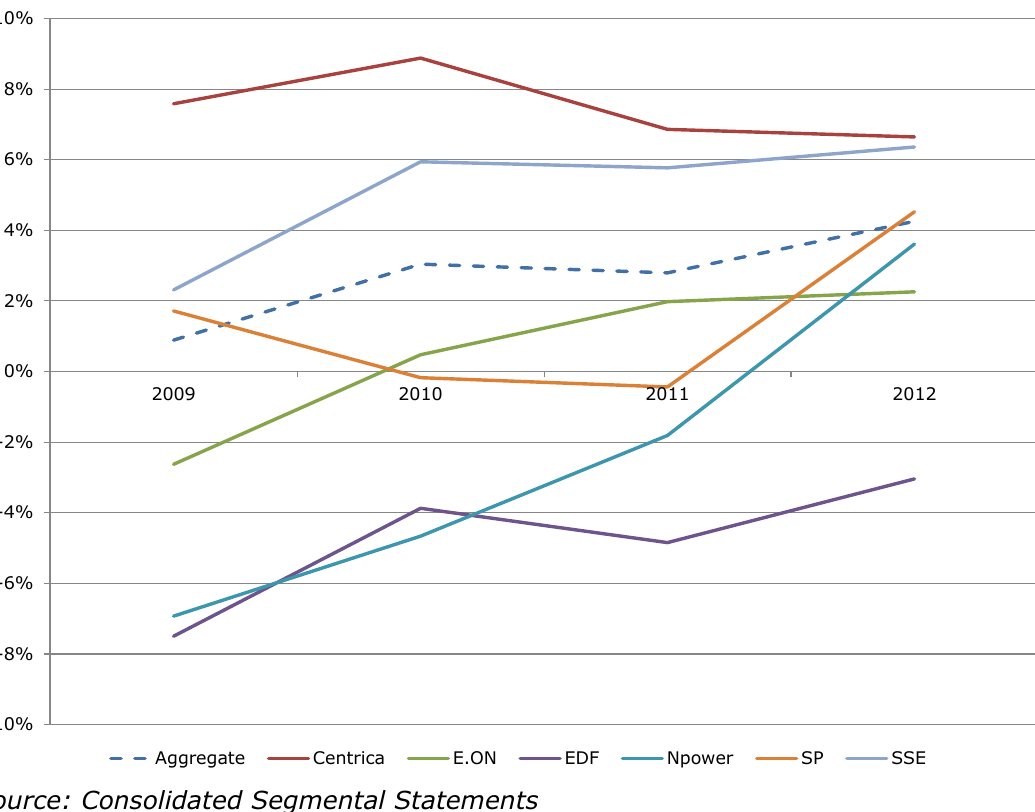
Figure 30: Domestic supply margins 2009 to